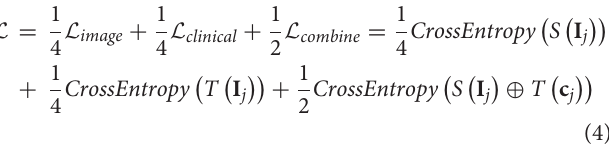
maps were summed to produce the output of this inter-spatial attention